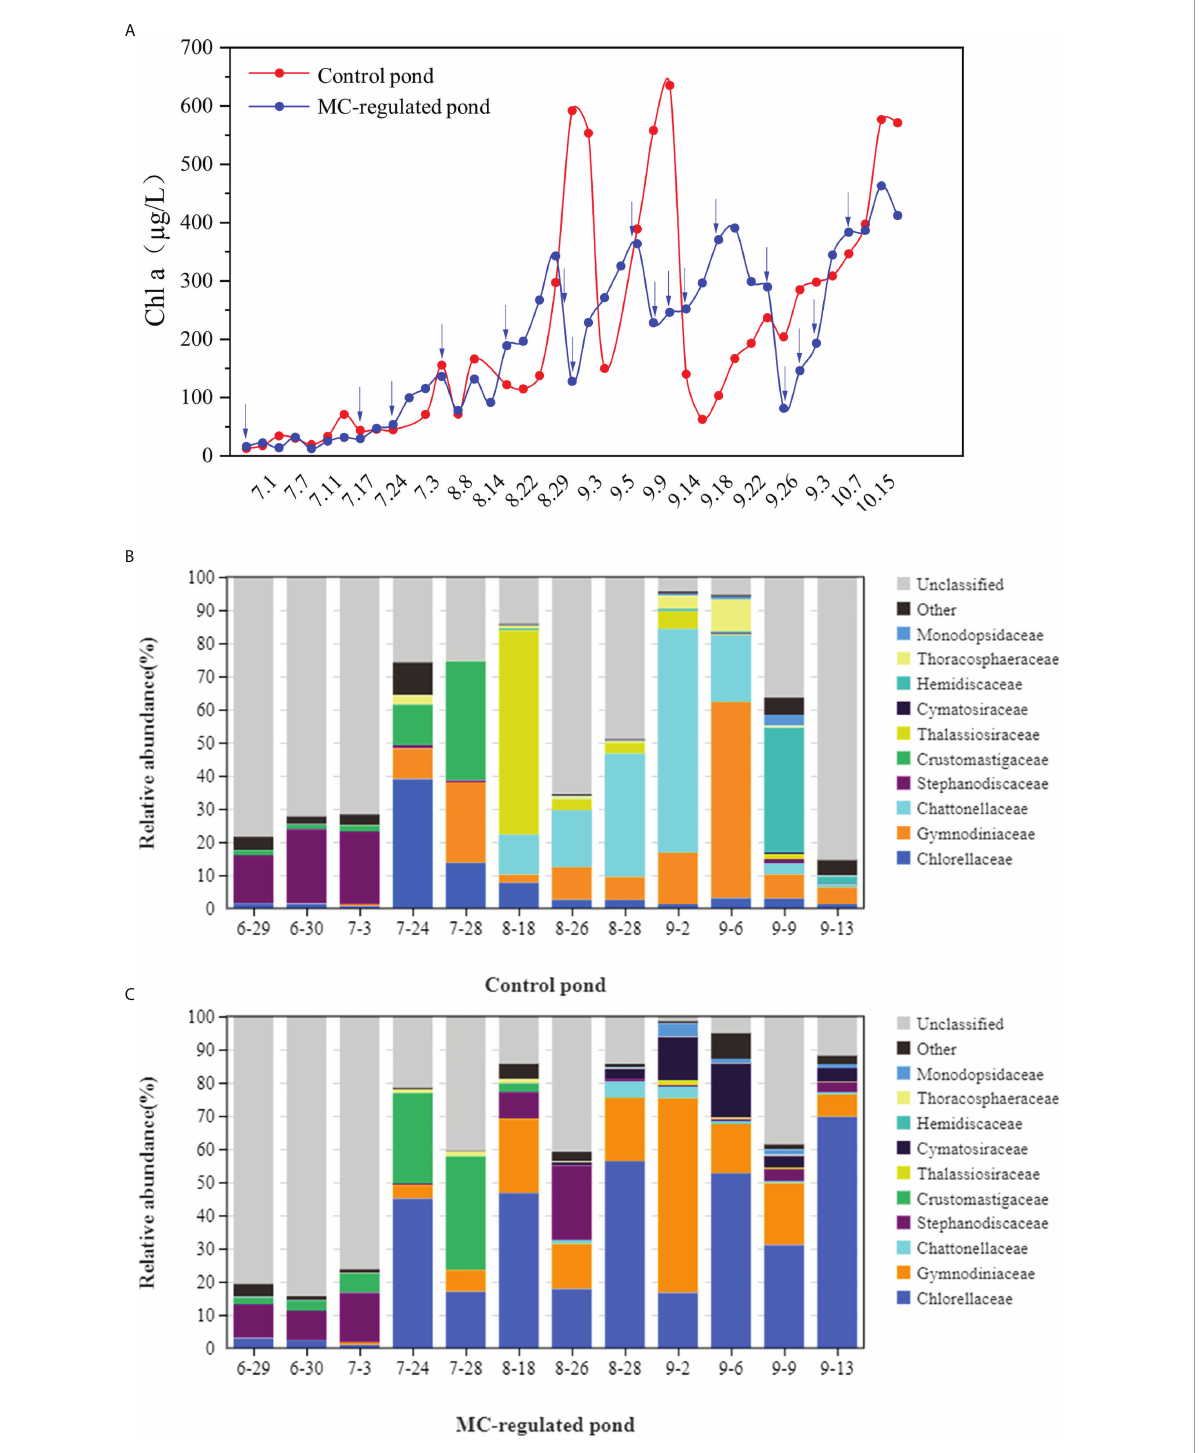
FIGURE 4 Temporal variations in the (A) Chl a concentrations and relative abundance of major taxa of phytoplankton in (B) the control pond and (C) MC- regulated pond at the family level. The blue arrows indicates the date when MC was